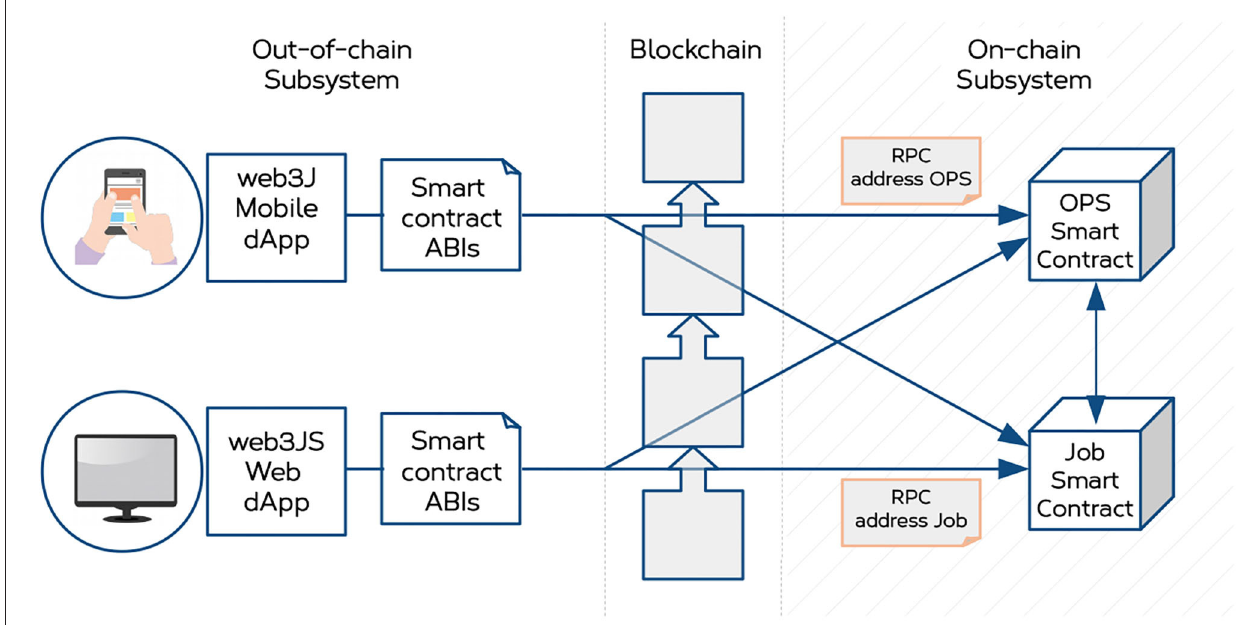
FIGURE 4 | A representation of the BOS system in its two main components and of the communication channel between the two components. The out-of-chain component (user interface) interact with the on-chain component (smart contracts) by means of remote procedure calls through the blockchain.